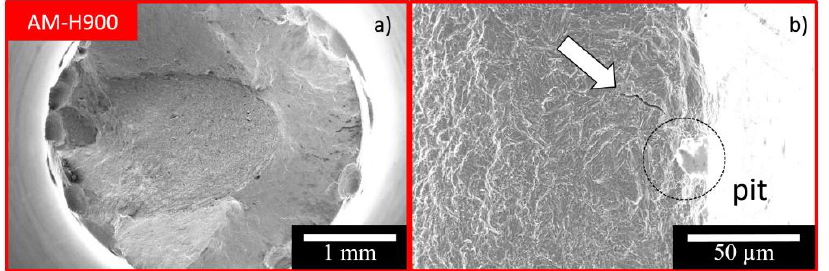
Figure 7. SEM observation of the fracture surface of an AM sample after an EAC test (sample maintained at the OCP and then polarised): ( a ) General view; ( b ) focus on a small crack initiated on pits (white arrow).